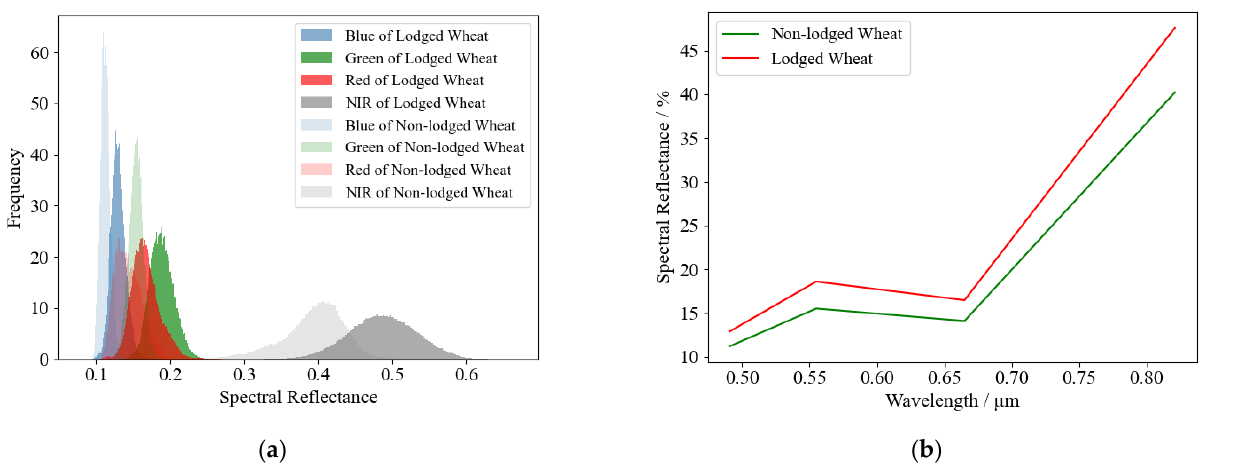
Figure 8. Changes in spectral reflectance of each band: ( a ) histogram of spectral reflectance in four bands; ( b ) mean spectral reflectance change within each band and wheat lodging conditions.